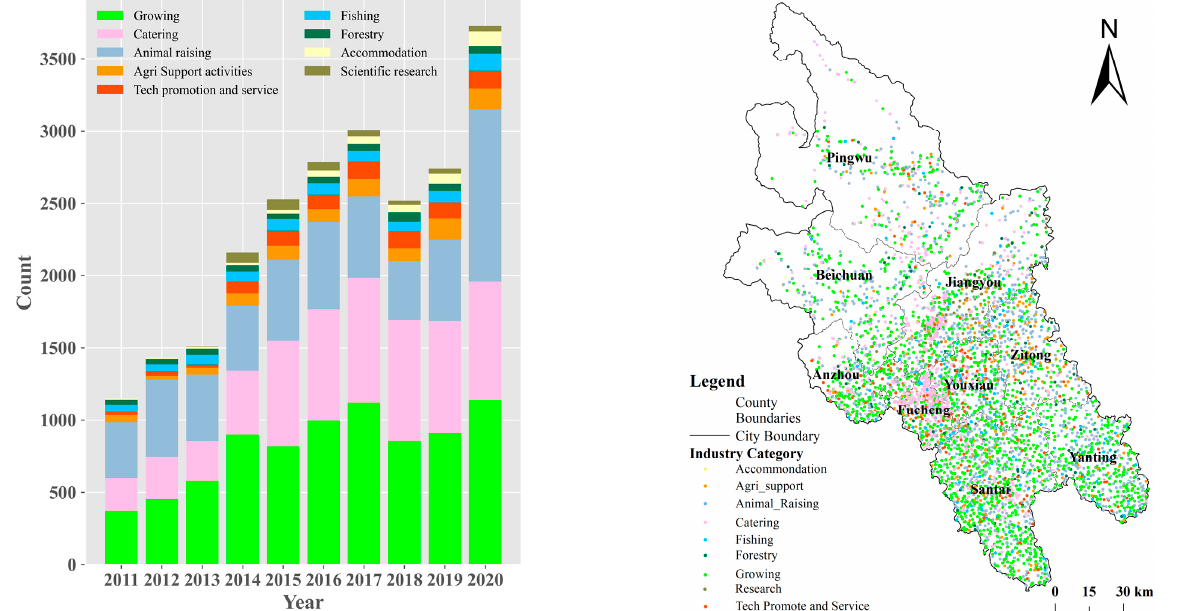
Figure 6. Industry category ( left panel) and distribution of industry type ( right panel) of rural en- trepreneurship of Mianyang from 2011 to 2020.